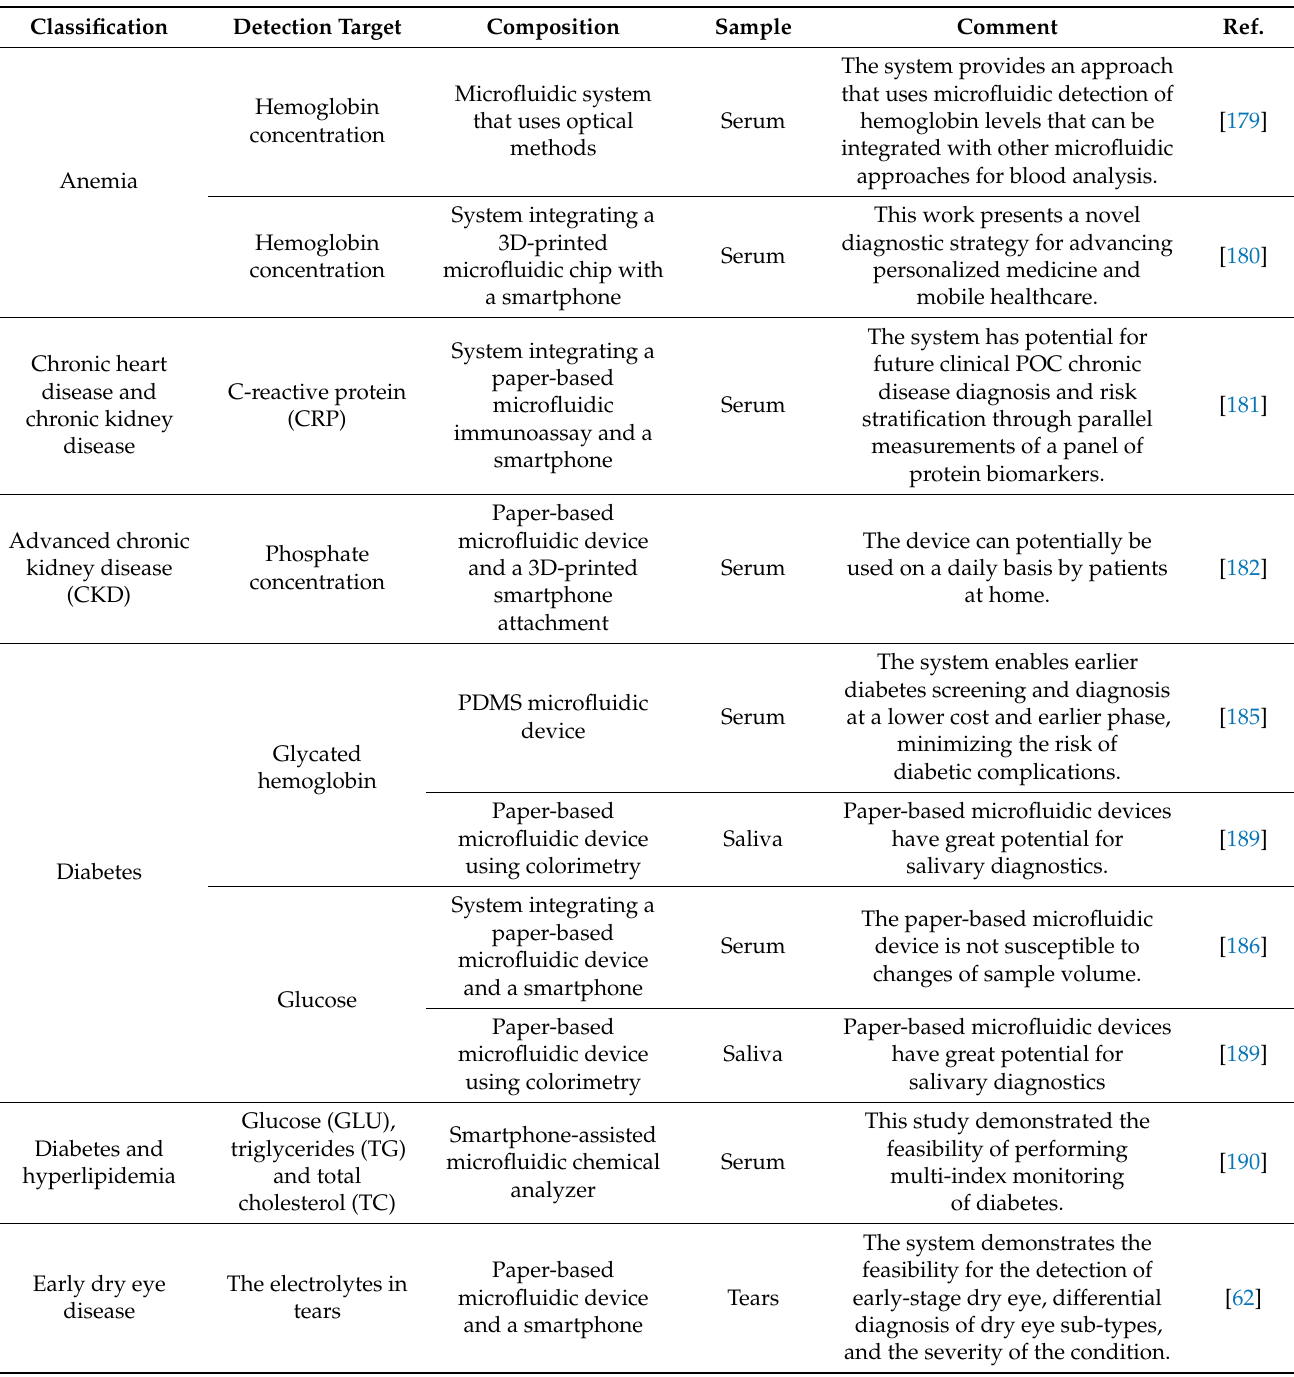
Table 6. The overview of applications of microfluidic POC devices in the early diagnosis of chronic